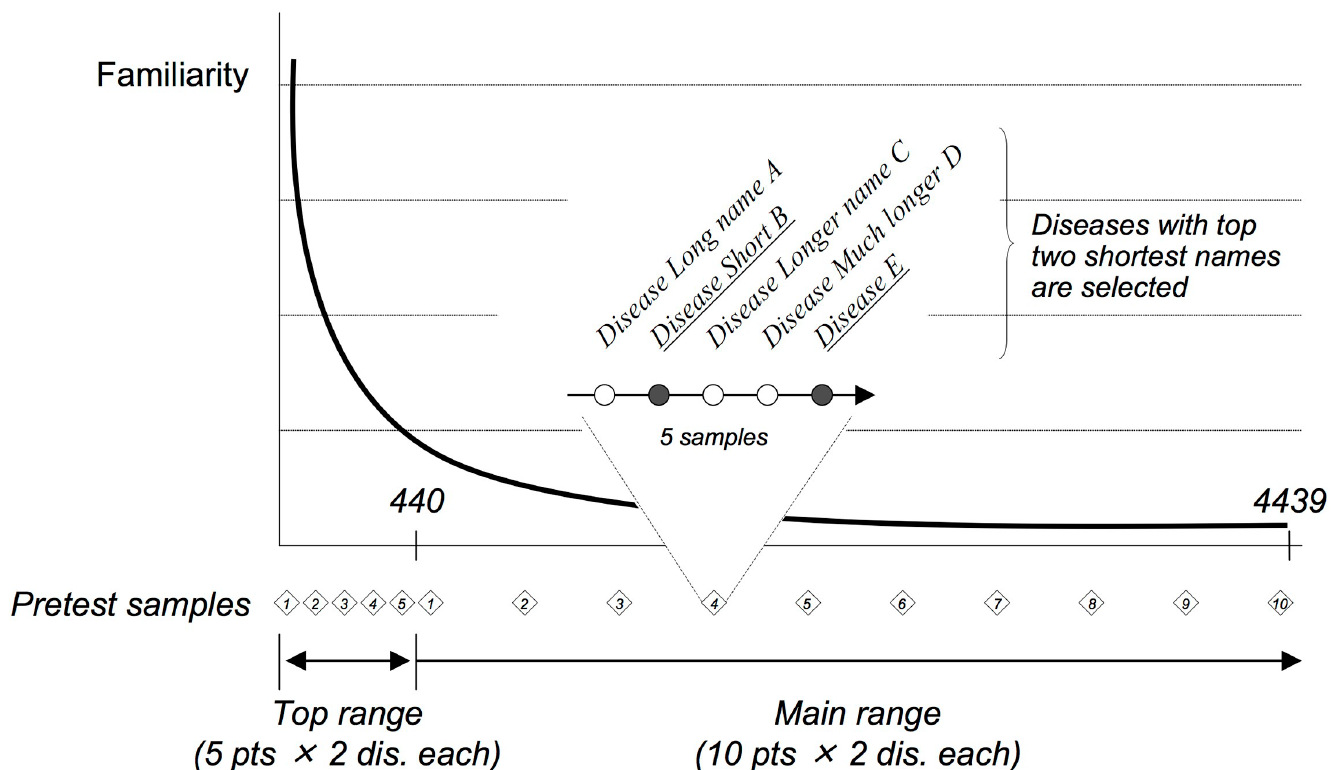
Fig 2. Pretest design: Breakdown of 30 samples used.